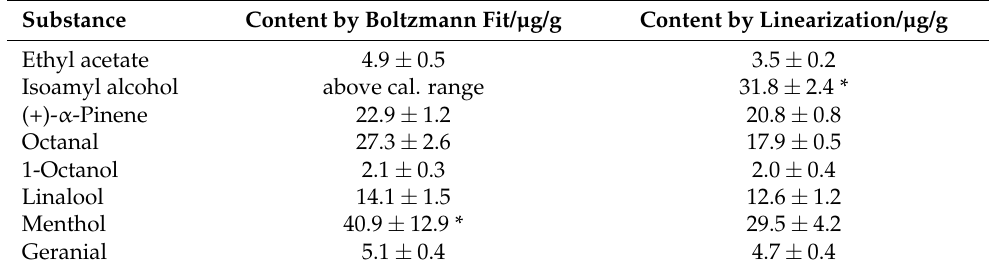
Figure 9. Recovery, as calculated using two different regressions for the calibration, for two different spiked concentrations and a selected set of substances in a flavorless e-liquid, with triplicate measurements. Table 3. The quantification results for the substances found and calibrated for the banana-flavored e-liquid, from a quadruplicate measurement and converted to substance amount in the pure